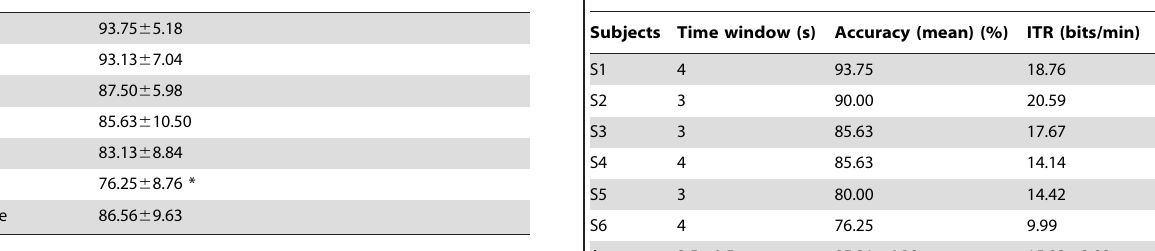
and S6 at 14 Hz (target vs. non-targets: p = 0.030 and p =0.071). Table 2. Offline highest ITRs on optimal time window